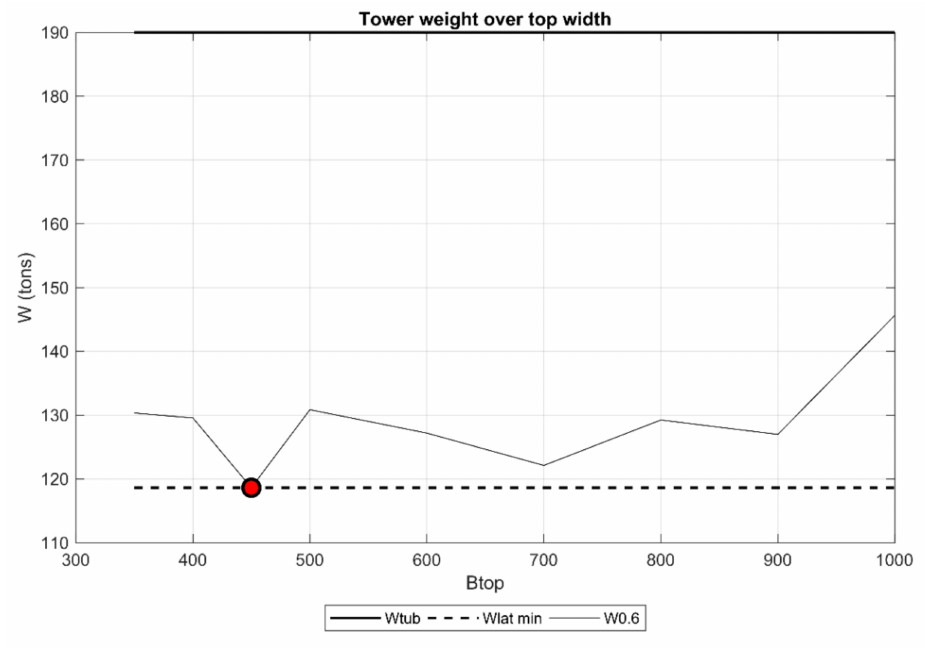
Figure 17. Weight of tower cases for µ = 0.6 in correlation with Btop for the 105 m towers.